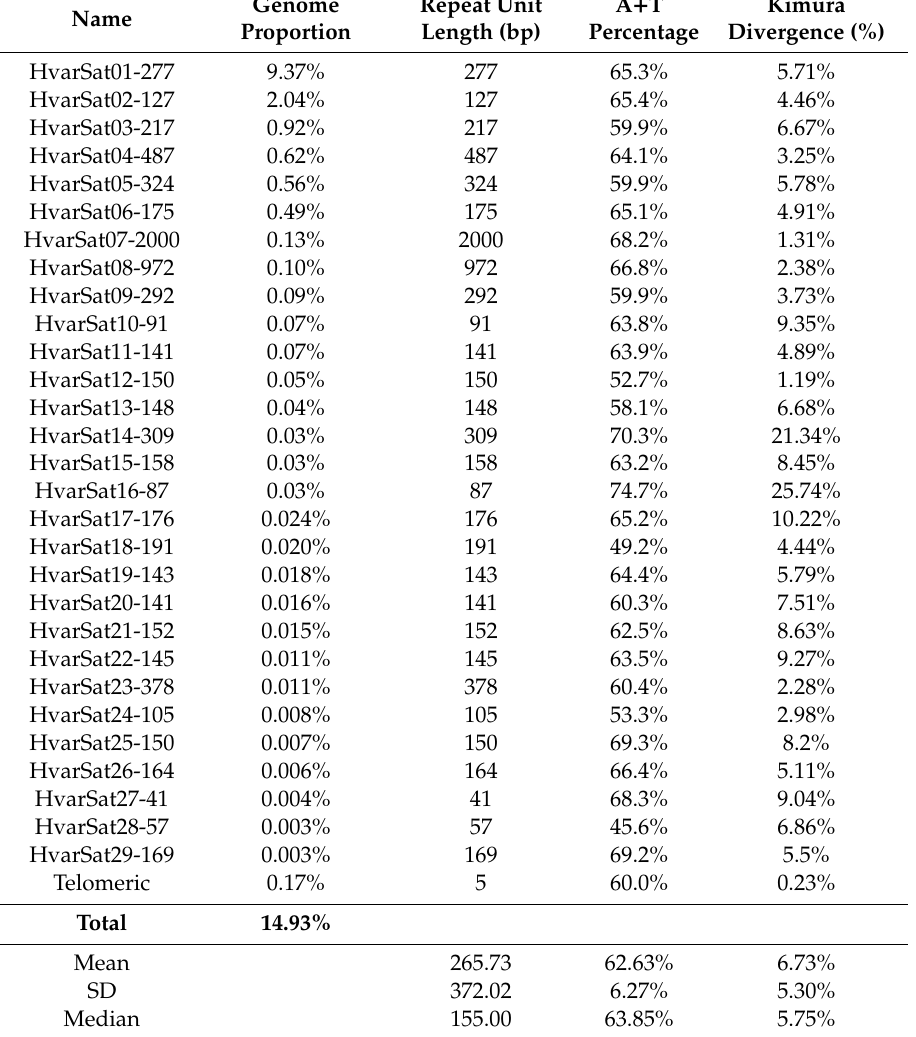
Figure 2. RepeatExplorer report showing the total amount of reads used as well as the number of clusters generated. Table 2. Data of the satDNA families found in Hippodamia variegata : genome abundance (%), length of the repeat unit, A + T content and divergence (%).